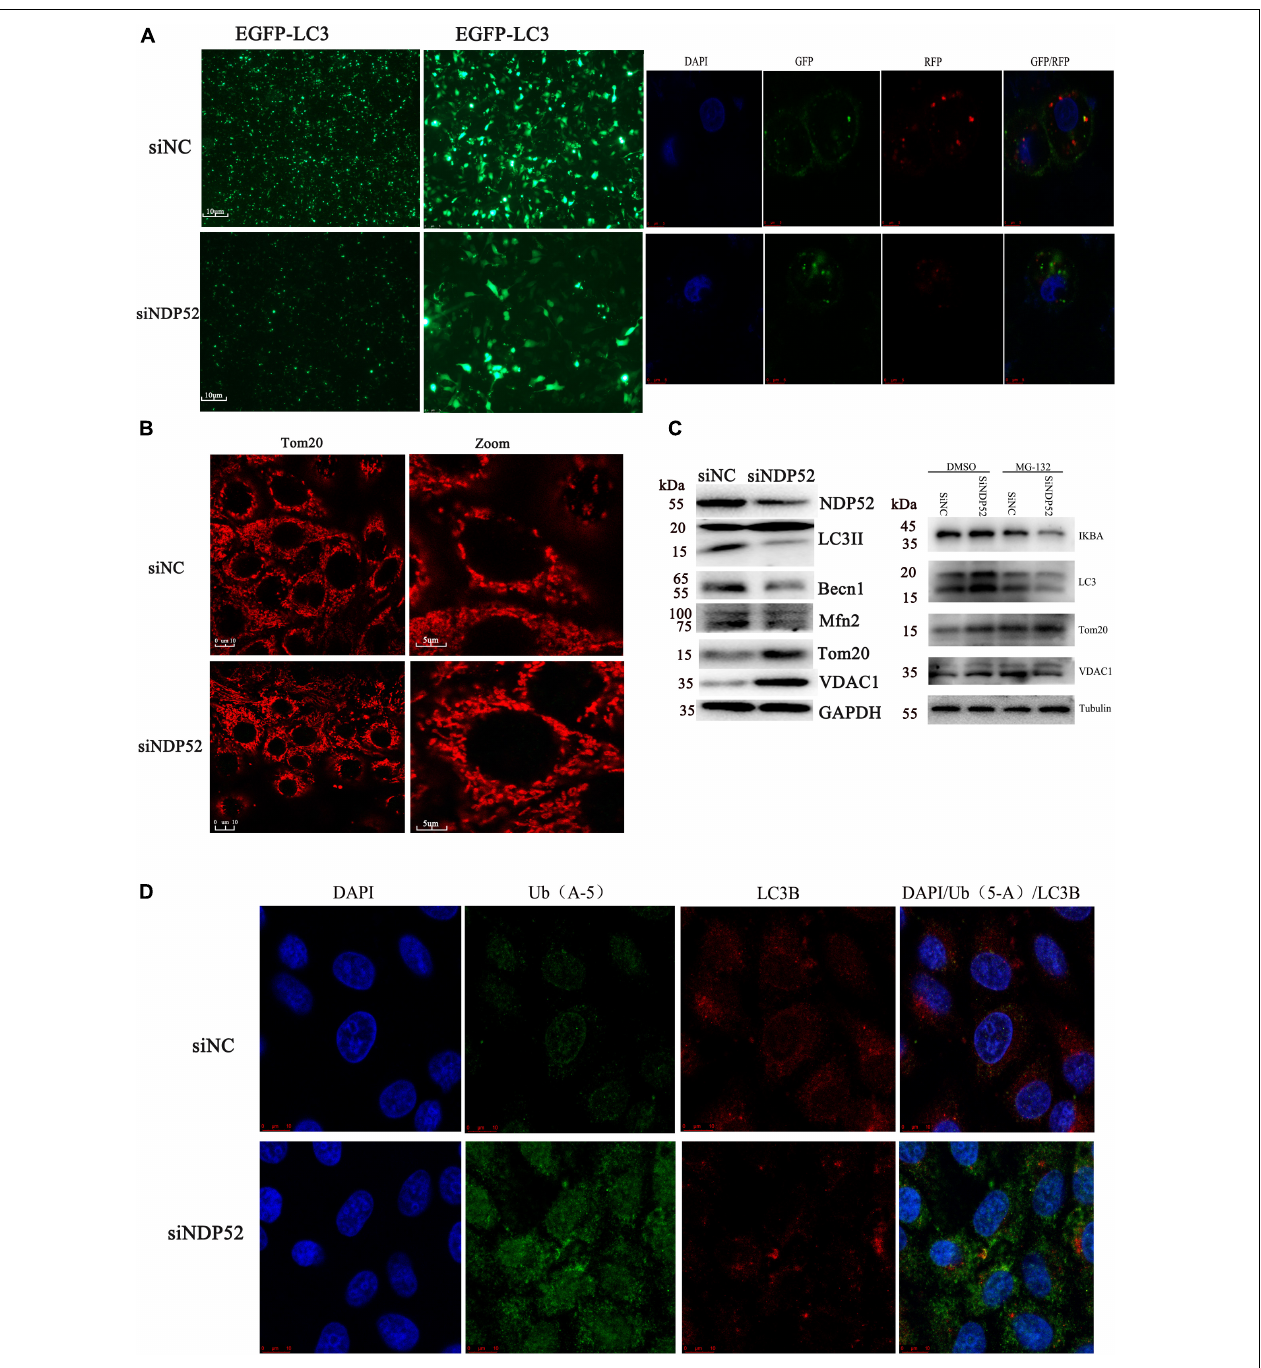
FIGURE 4 | Inhibition of NDP52 reduces autophagy and mitophagy, and decreases ubiquitin and LC3 binding. (A) PK-15 cells were transfected with scrambled or NDP52 siRNA for 24 h. Then, cells were transfected with EGFP-LC3 or GFP-RFP-LC3 plasmid or immunostained with antibodies against LC3 (red). After NDP52 inhibition, eGFP levels were significantly reduced, the yellow dots were more than red dots and the LC3B expression in the cytoplasm. (B) PK-15 cells were treated as above, after 24 h transfection, cells were immunostained with antibodies against Tom20 (red). After NDP52 inhibition, Tom20 expression was enhanced. (C) The expression of the autophagy markers, LC3 and Beclin-I, and mitophagy markers, Mfn2, VDAC, and Tom20, in PK-15 cells were analyzed by Western blotting after transfection with scrambled or NDP52 siRNA for 24 h. GAPDH was used as the internal loading control. The expression of I κ B-a, LC3, VDAC, and Tom20 in PK-15 cells were analyzed by Western blotting after co-transfection with scrambled or NDP52 siRNA with DMSO or MG-132 for 24 h. Tubulin was used as the internal loading control. (D) Ub(A-5) (green) and LC3 (red) expression in PK-15 cells. In the merged images, protein colocalization is displayed as yellow.